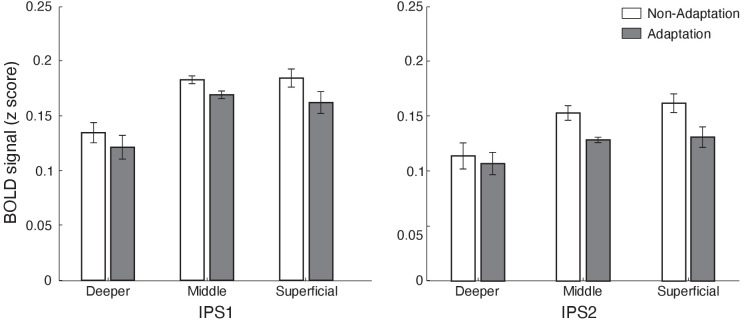
Laminar BOLD for IPS1 and IPS2.Mean BOLD in IPS1 and IPS2 across cortical layers. Bar-plots show z-scored BOLD signal for adaptation (grey) and non-adaptation (white) across cortical layers of IPS1 and IPS2. Error bars indicate within-subject confidence intervals (Cousineau, 2005) (N = 15).Figure 4—source data 1.Tables for mean BOLD responses to adaptation and non-adaptation across cortical layers of IPS1 and IPS2.